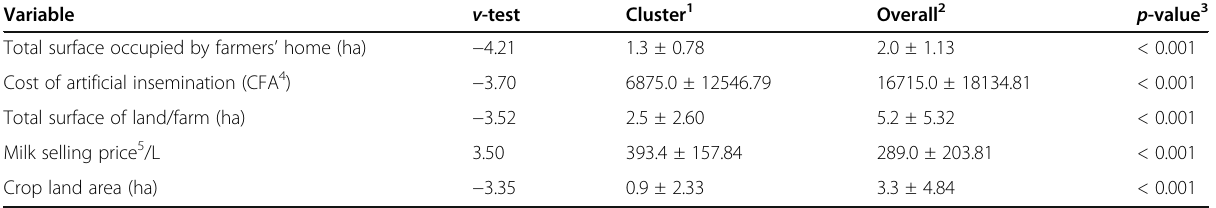
Table 4 Top 5 relevant quantitative variables that best describe the 32 farms from cluster 2. Overall sample n = 100 farms Variable